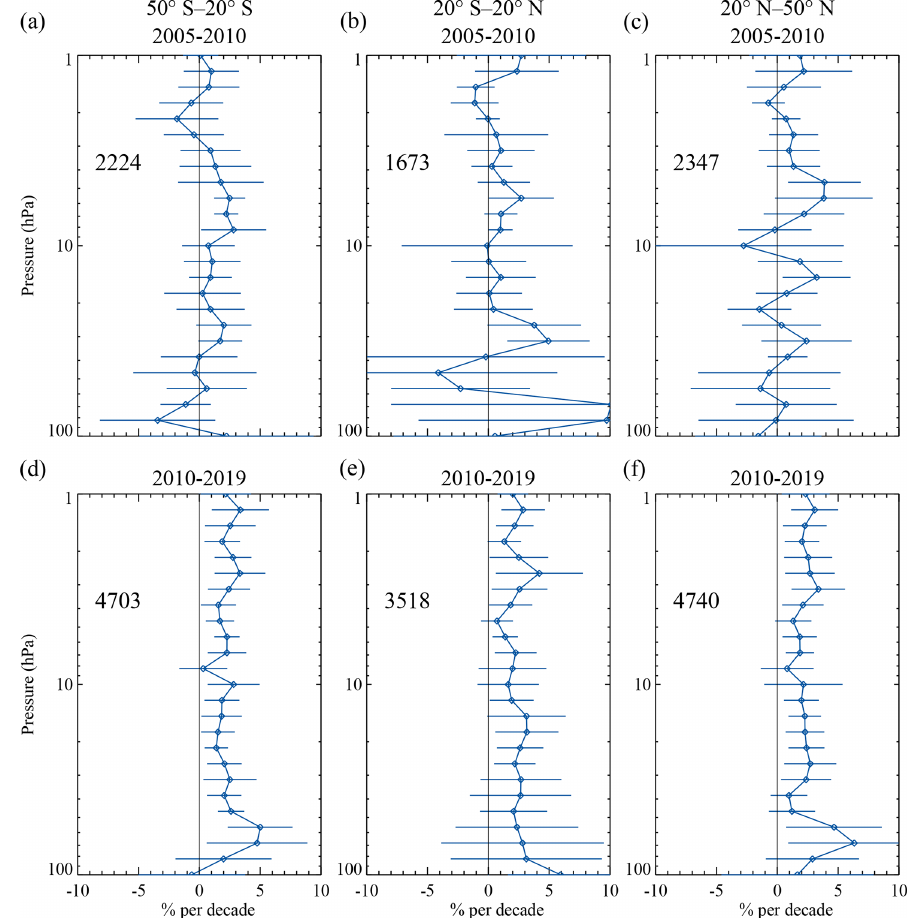
Figure 2. Drifts between MLS v4 and ACE-FTS version 4.1 observations of stratospheric water vapor for various latitude bands (columns) for 2005–2010 (a–c) and 2010–2019 (d–f) . Numbers in each panel denote the total number of coincident (within ± 1 ◦ latitude, ± 8 ◦ longitude, and ± 12h) MLS/ACE observations, and error bars denote the 2 σ block bootstrap interval for the linear fit term. Positive numbers imply that MLS values are drifting upwards compared with those from